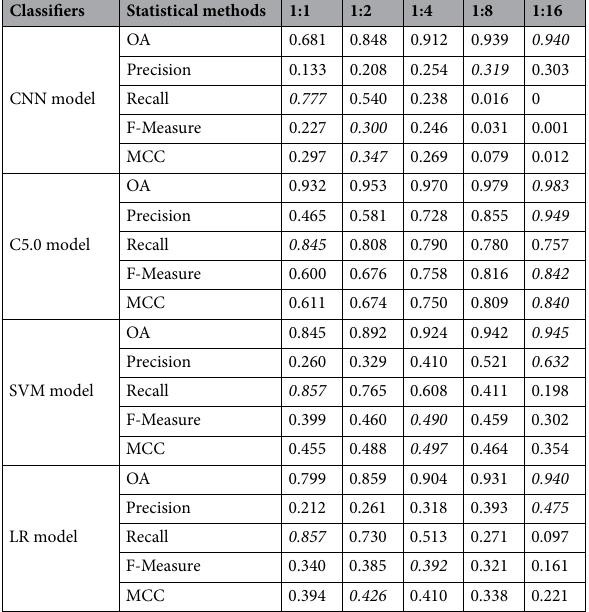
model has the best calculation results in the 1:4 sample set, and the two values are 0.490 and 0.497, respectively. The F-measure of the LR model appears in the 1:4 sample set, which is 0.392, and the MCC is the largest in the 1:2 sample set, which is 0.426. In general, among these five indicators, especially the F-measure and MCC, which can be applied to comprehensively evaluate the classification performance of the model in the presence of an imbalanced sample set 59 , the results of the model on the LSM of the balanced sample set are not the best. Specific category precision analysis. To increase the readability of the LSI map, all LSIs are divided into five susceptibility categories using the equal interval method according to the calculation results: very low sus- ceptibility (0–0.2), low susceptibility (0.2–0.4), medium susceptibility (0.4–0.6), higher susceptibility (0.6–0.8), and very high susceptibility (0.8–1.0). The SCPA results of LSM based on unbalanced sample sets and different models are shown in Table 9 and Fig. 12. According to the results in Table 9, in the CNN model, 4.06% of the results based on the 1:2 sample set with very high susceptibility are higher than 3.39% of the 1:1 sample set, and the results in the 1:4 sample set and later sample sets are all 0. The result of the overall sample set is also 0 in this sample set. The results of the C5.0 model have an obvious increasing trend with the decrease of the sample set, and the best result is in the 1:16 sample set (95.60% of the overall sample set and 51.87% of the validation sample set). The SVM model in the overall sample set also achieves the maximum value of 71.16% in the 1:16 sample set. However, in the validation sample set, the 10.54% result of the 1:2 sample set is the best. In the LR model, the results for the validation sample set range from 7.60% for the balanced sample set to 7.09% for the 1:2 sample set, which is a slight drop in percentage. For the four different models, from SCPA of the very high susceptibility, the results of the imbalanced sample set are better than the results of the traditional training model based on the balanced sample set. Discussions